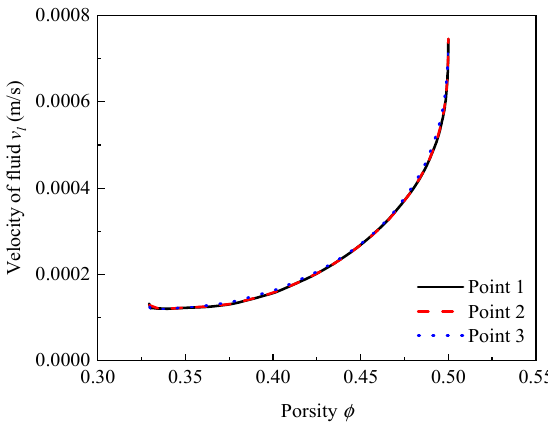
Figure 15. The relation curves between fluid velocity and porosity.